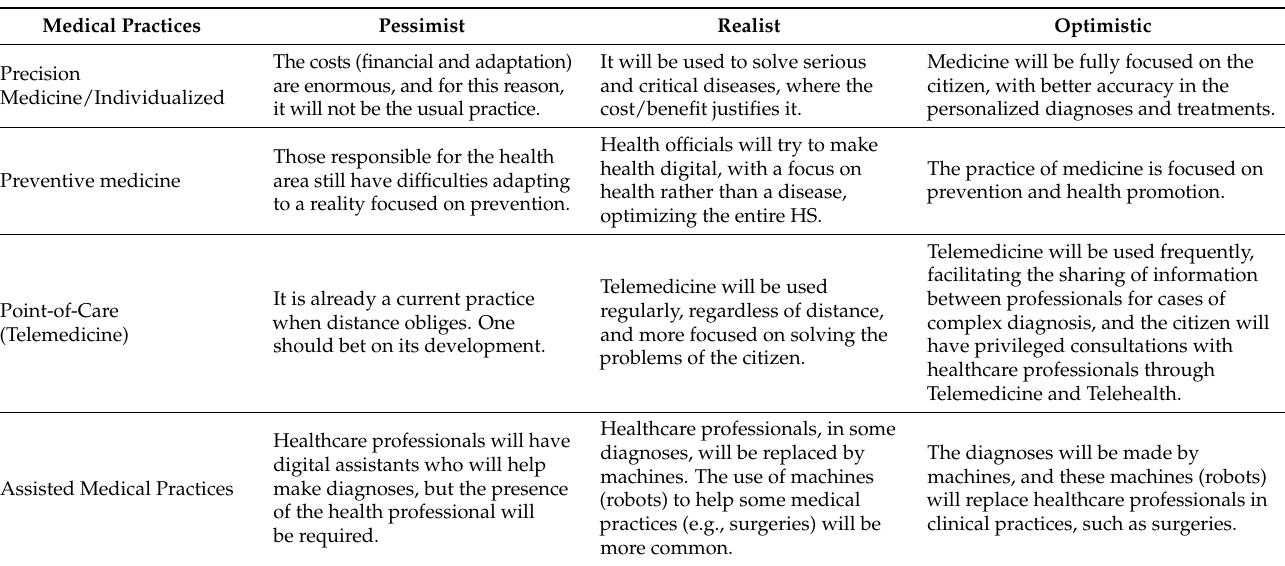
Table 3. Scenarios for Medical Practices.